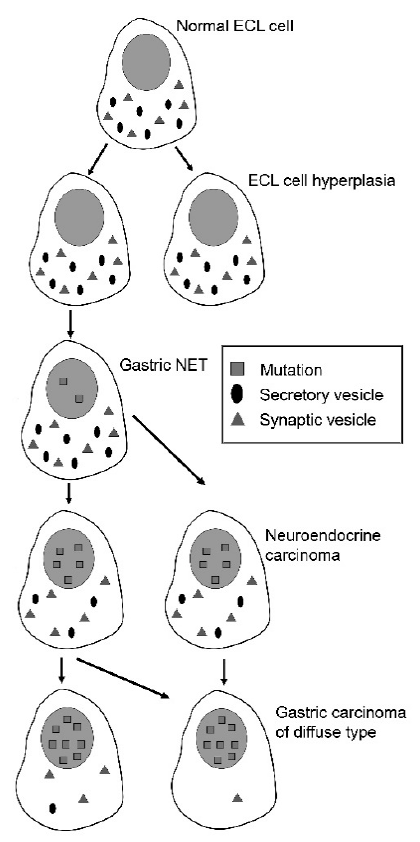
Figure Figure 2. Proposed carcinogenesis for gastric carcinomas of diffuse type (From ref 78 with permission [82]).